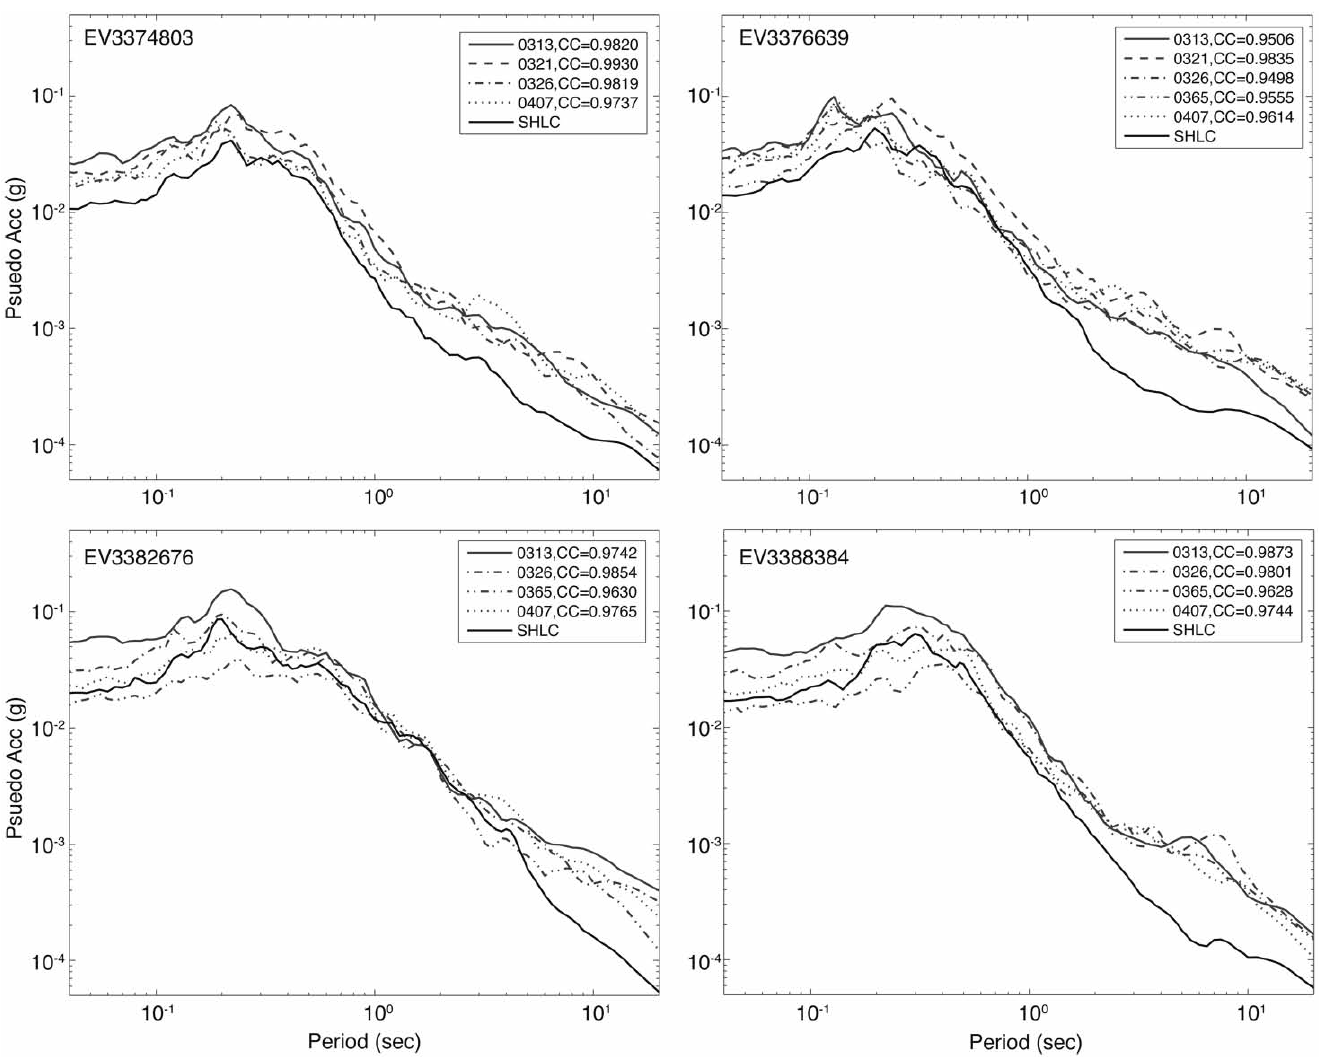
Figure 6. Horizontal component average pseudo acceleration response spectra for the GeoNet and QCN stations shown in Figure 4. Response spectra were computed for earthquakes (a) 3374803, (b) 3376639, (c) 3382676, and (d) 3388384 (See Table 1 for more information). Cross-correlation coefficients are computed between the QCN stations and GeoNet station SHLC and reported in the